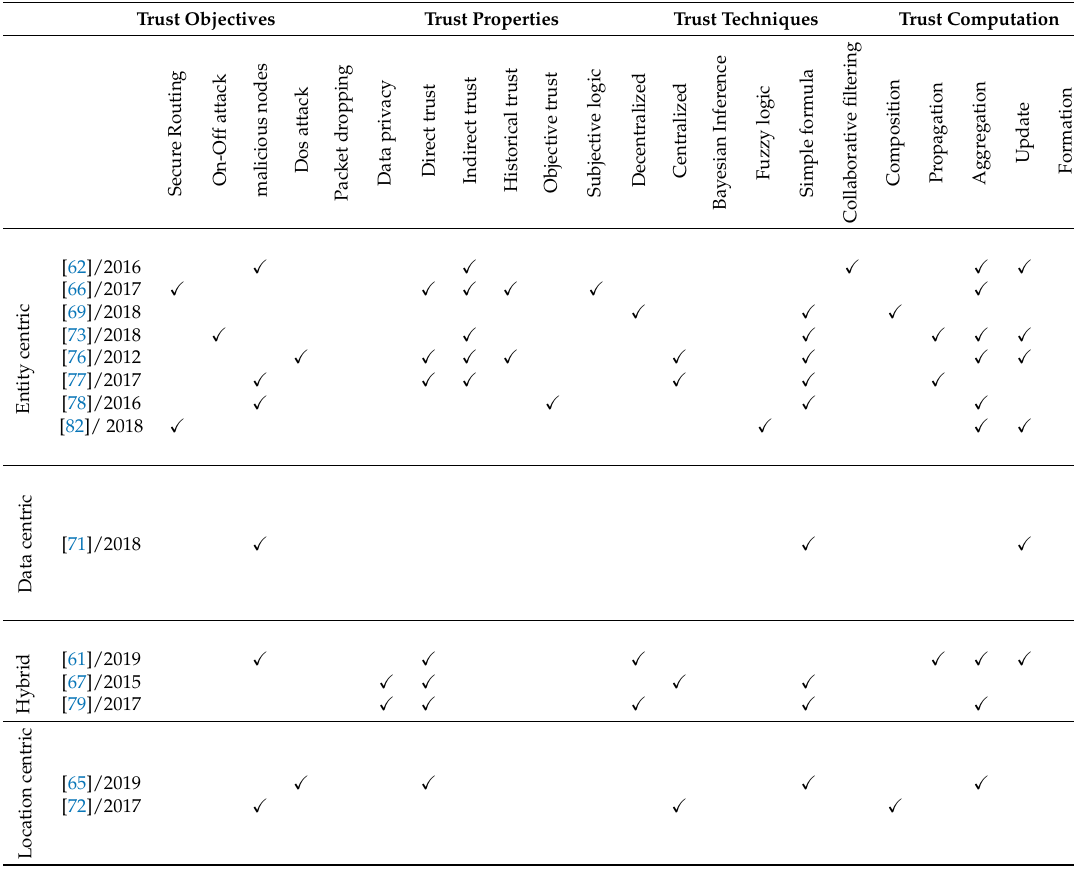
Table 6. New classification of trust management approaches in WBAN Trust Objectives Trust Properties Trust